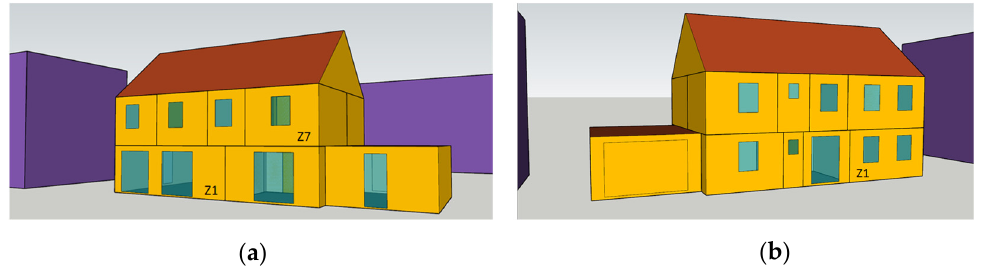
Figure 1. views of the main facades with indication of the considered thermal zones (Z1: living 81 Figure 1. Views of the main facades with indication of the thermal zones considered (Z1: living room, room, Z7: main bedroom). (a) Rear façade (east oriented). (b) Front façade (west oriented). 82 Z7: main bedroom). ( a ) Rear façade (east oriented). ( b ) Front façade (west